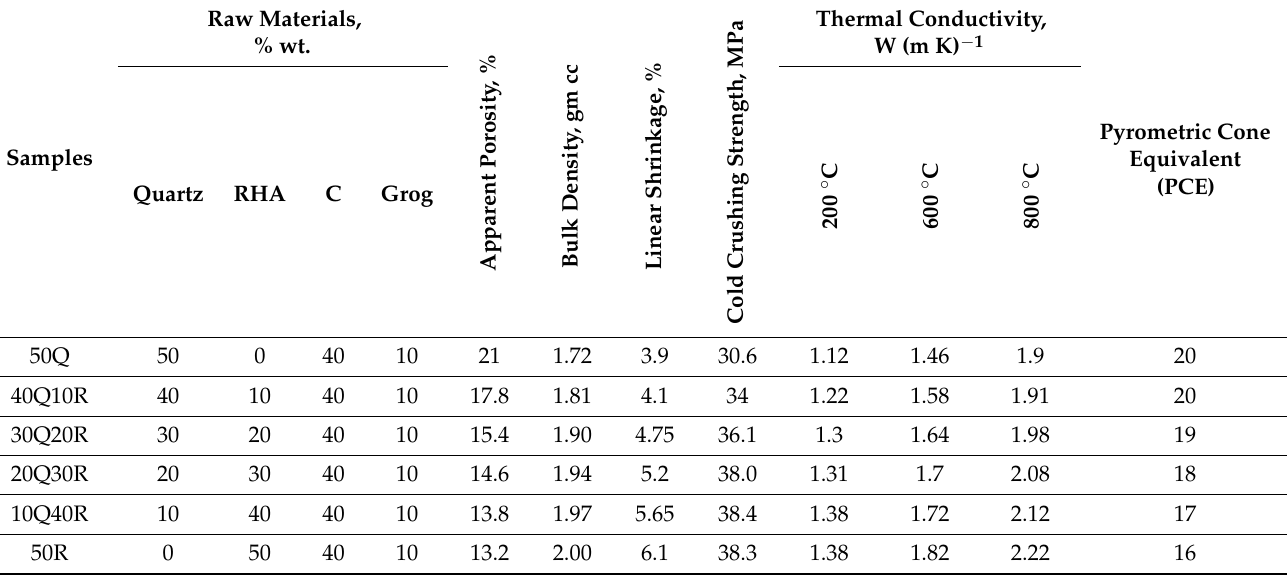
Table 10. Composition and properties of quartz/RHA/clay/grog refractories. Data from